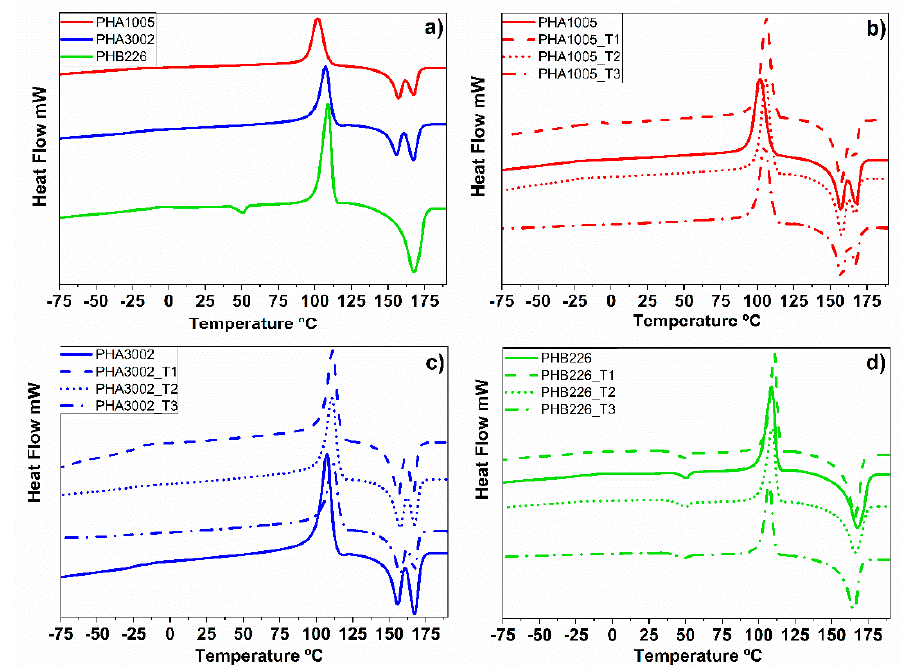
Figure 2. Di ff erential scanning calorimetry (DSC) thermograms. ( a ) Raw matrices: PHA1005, PHA3002 and PHB226; ( b ) PHA 1005 loaded with 3 wt.% T1, T2 and T3; ( c ) PHA 3002 loaded with 3 wt.% T1, T2 Figure 2. Differential scanning calorimetry (DSC) thermograms. ( a ) Raw matrices: PHA1005, and T3; ( d ) PHB 226 loaded with 3 wt.% T1, T2 and PHA3002 and PHB226; ( b ) PHA 1005 loaded with 3 wt. % T1, T2 and T3; ( c ) PHA 3002 loaded with 3 wt. % T1, T2 and T3; ( d ) PHB 226 loaded with 3 wt. % T1, T2 and T3.